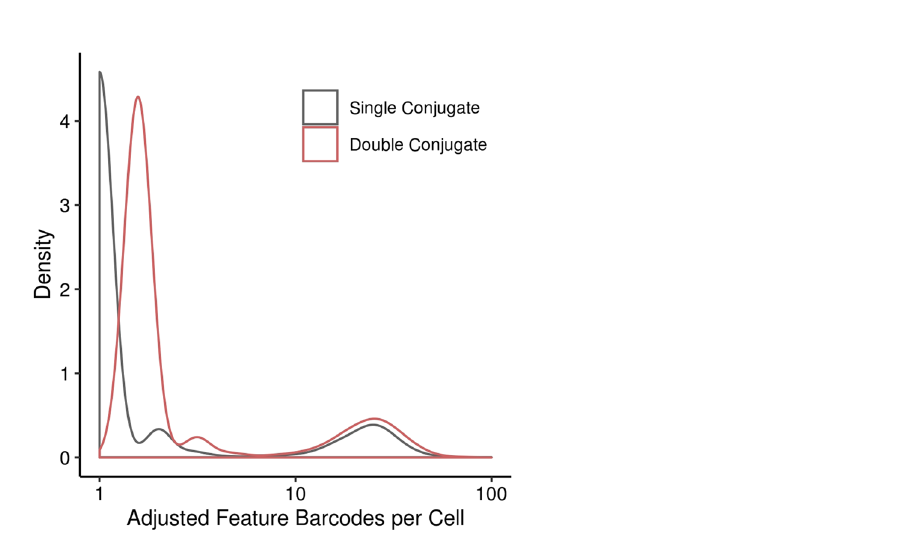
Figure 6. Distribution of feature barcode binding events per single cell in a CiteSeq experiment with single and double oligonucleotide-conjugated anti-CD49e. Double oligonucleotide-conjugated anti-CD49e increase the number of retrieved sequencing reads per HUVEC. The number of reads per cell was corrected for UMI duplication and adjusted by the total read number per